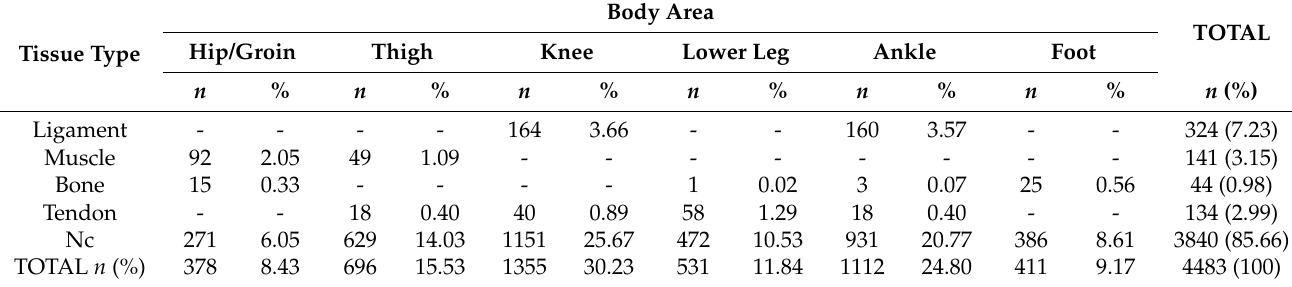
Table 2. Distribution of lower limb injuries ( n y %) in handball players according to body area and tissue type.